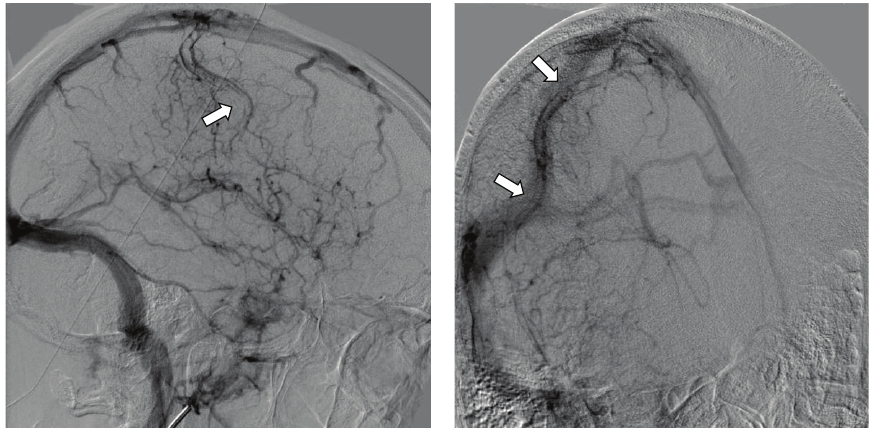
Figure 3: Cerebral angiography. Venous phase image of the right internal carotid artery shows a tubular filling defect within the superficial cortical vein of Trolard (arrow) and engorgement of the surrounding venules, suggestive of thrombosis of the vein of